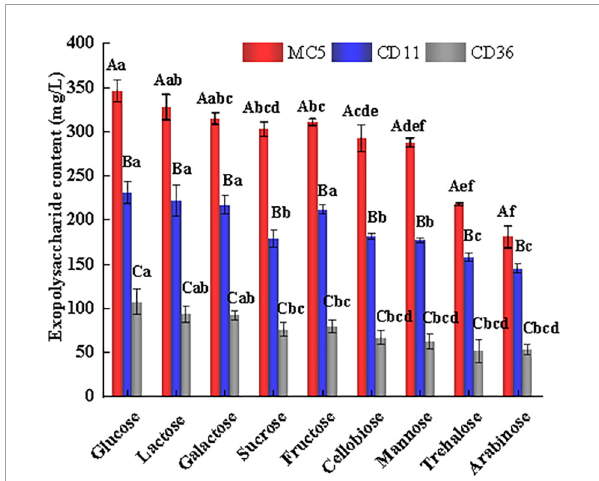
FIGURE8 Sugar metabolism types and EPS production of Lp. plantarum MC5 (red column). Experiments were repeated three times. Lp. plantarum CD11 and Lp. plantarum CD36 (blue and gray columns) were the control groups for moderate EPS production and low EPS production, respectively. Capital letters (A, B, and C), respectively, represent the differences in EPS produced by different strains using the same carbon source ( p < 0.05). Lowercase letters (a, b, c, d, e, and f) represent the differences between EPS produced by the same strain using different carbon sources ( p < 0.05). ANOVA tests were used to determine significant differences between treatments with a significance level of p < 0.05 by the SPSS 22.0 package program. Error bars represent the standard errors (SE) of the mean value ( n = 3), and the experiment was repeated three